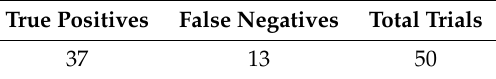
Table 6. Trials with users already registered in the database.